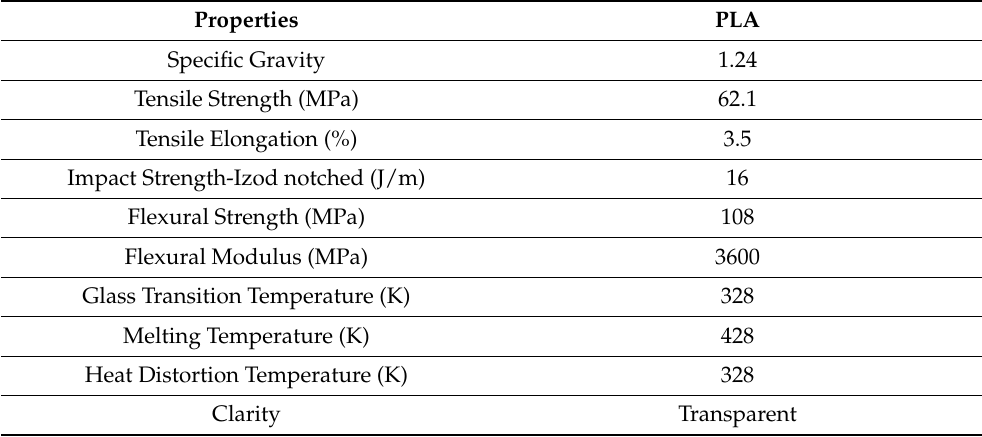
Table 6. General properties for PLA